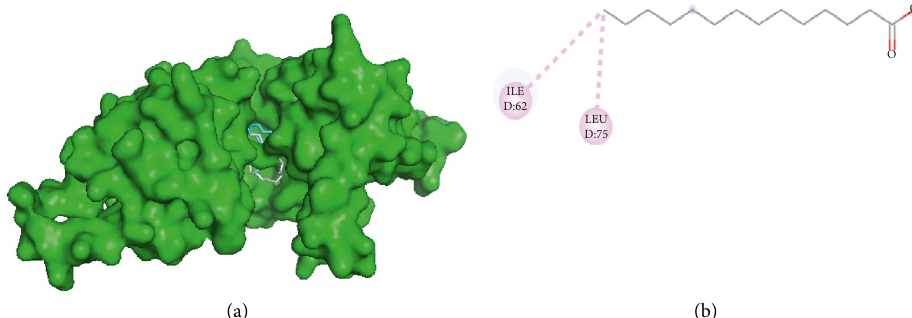
Figure 5: Interaction of myristic and palmitic acids with filaggrin. (a) 3D visualization: myristic acid (light blue) and palmitic acid (grey). (b) 2D visualization: amino acid residues in myristic acid and palmitic acid.